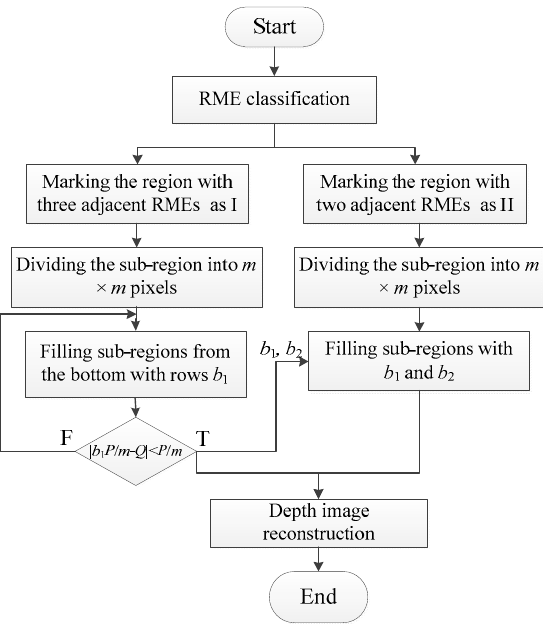
Figure 7. The method of depth image super-resolution reconstruction. Step 1. RME classification. The region with three adjacent RMEs is marked as